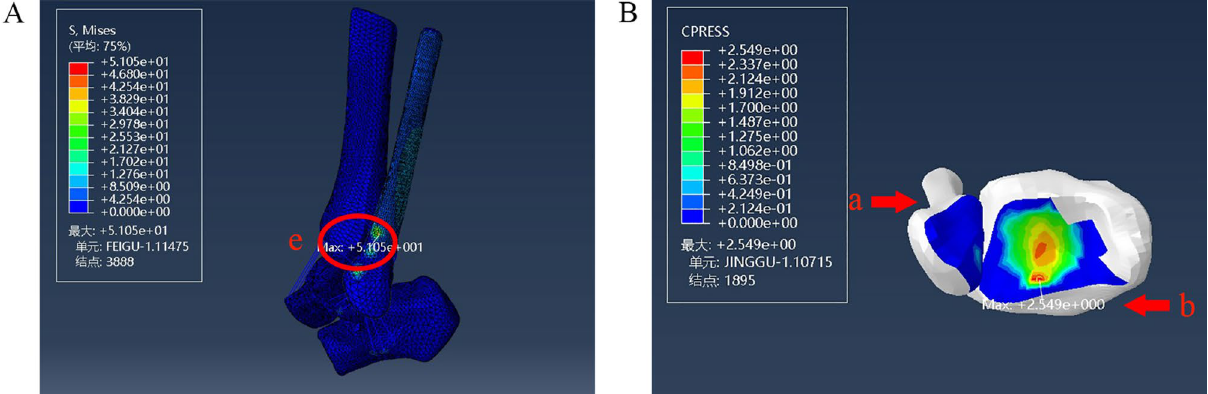
Figure 5. Stress distribution during a stage I supination-external rotation ankle injury. ( A ) Maximum stress view. ( B ) Maximum contact stress view. Units of measurement: Mpa. a: Tibia. b: Fibula. e: The anterior tibiofibular ligament.